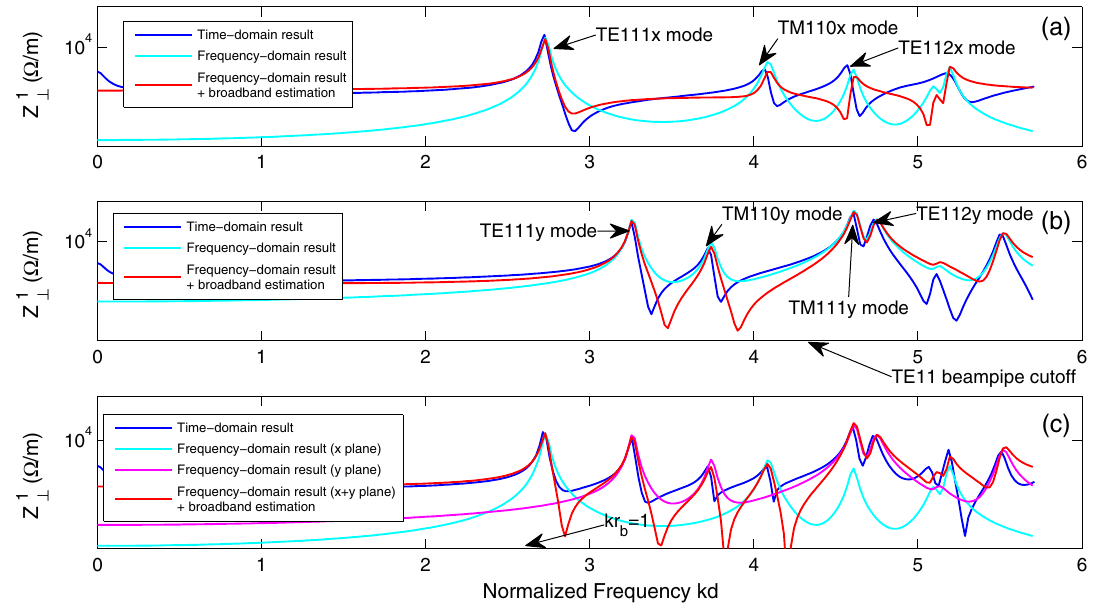
FIG. 5. Transverse wake impedances Z 1 ⊥ in an elliptical cavity ( a ¼ 1 . 75 b ) at different transverse planes: (a) the horizontal plane; (b) the vertical plane; (c) the ϕ ¼ 60 ° plane. In each figure, three impedance curves are compared: directly calculated impedance (blue curve), cavity-mode derived impedance (cyan or pink curve), and cavity mode derived impedance plus the broadband estimation (red